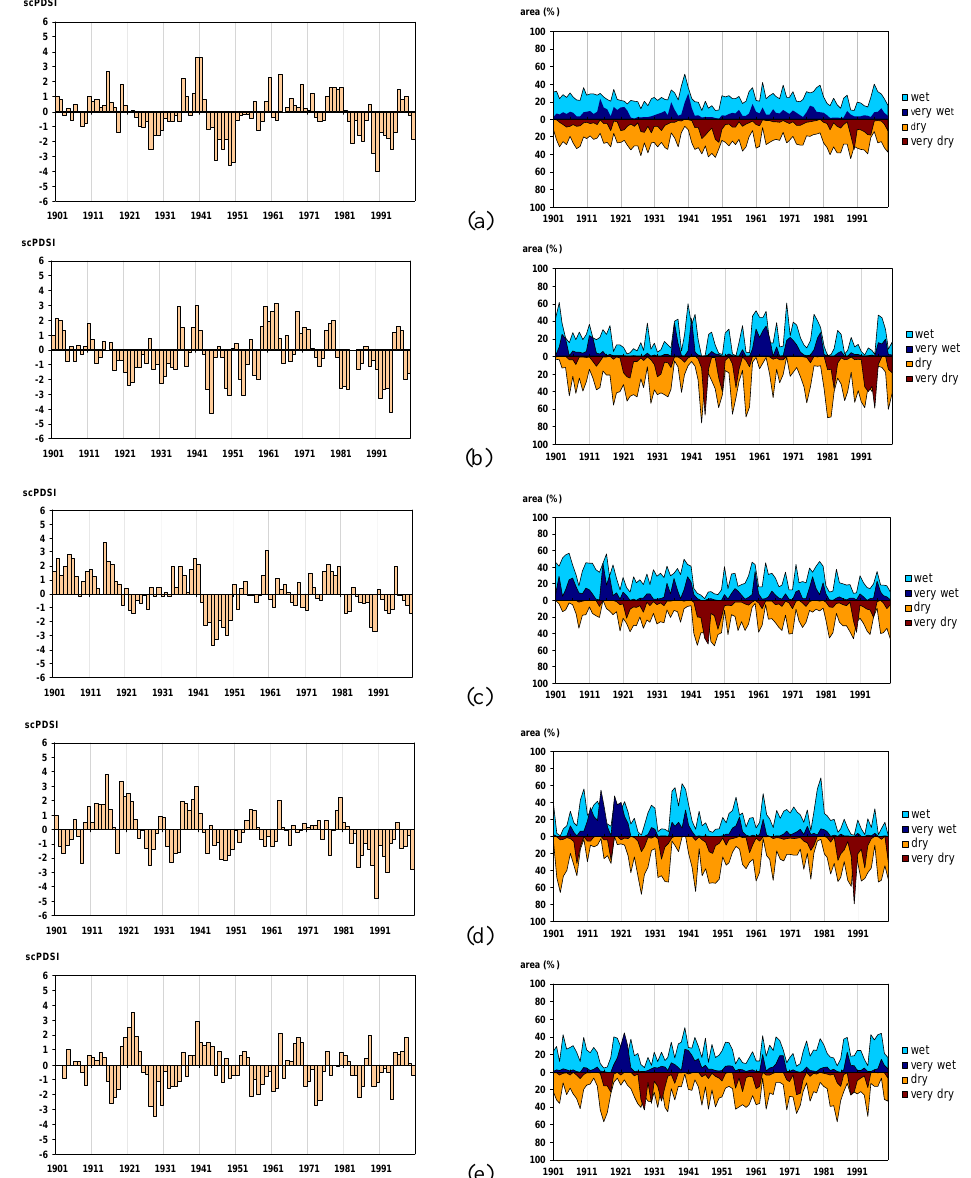
Fig. 5. Inter-annual variability of scPDSI (left) and corresponding percentages of area under wet (blue) and dry (orange) conditions (right) for the considered sub-domains: (a) the entire Mediterranean; (b) Iberia; (c) Italian Peninsula; (d) Balkans; (e)